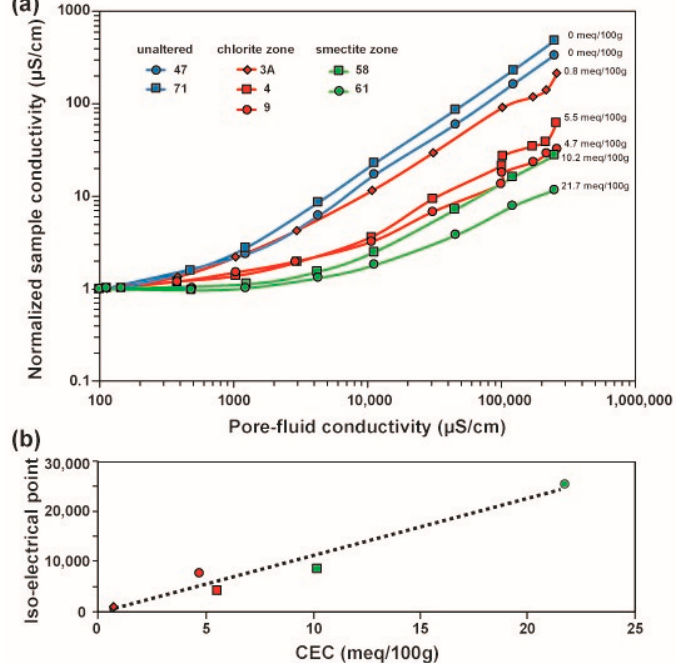
Figure 5. ( a ) Normalized core sample conductivity measurements at 1 Hz versus pore-fluid conductivity, adapted from [48] and the corresponding CEC results for the seven core samples (Table 1). ( b ) Iso-electrical points as a function of CEC (similar symbols used as in ( a )). The dash line shows the trend-line for all measurements.